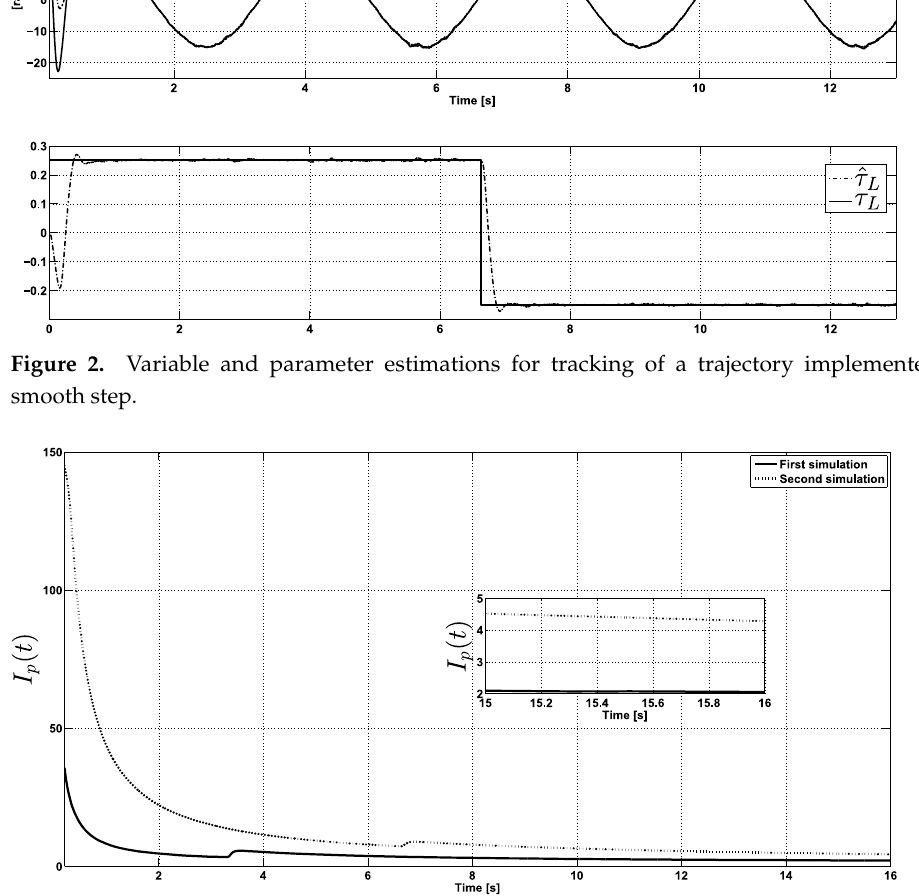
Figure 3. Performance index of the first and second